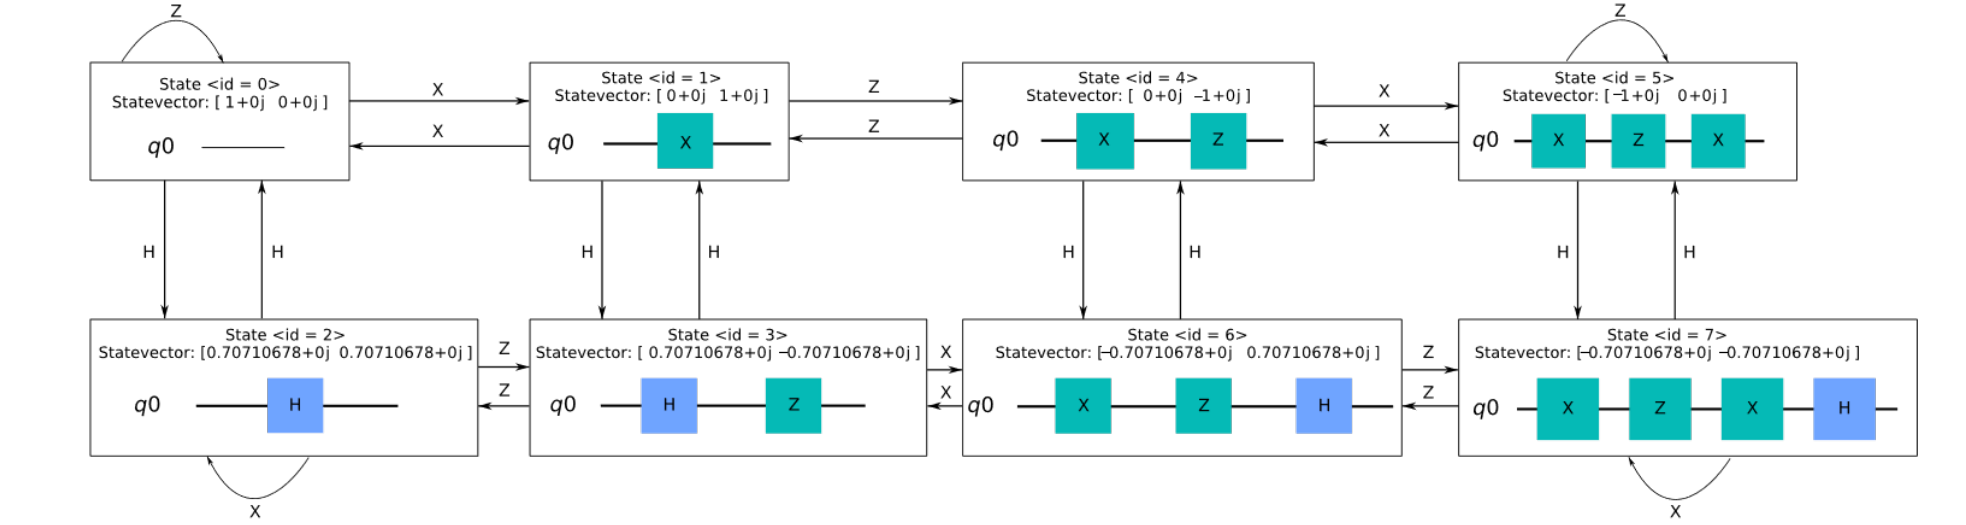
Figure 3. The graph for the presented example, with quantum states as nodes, for a one-qubit register and three selected gates (X, Z, and H).